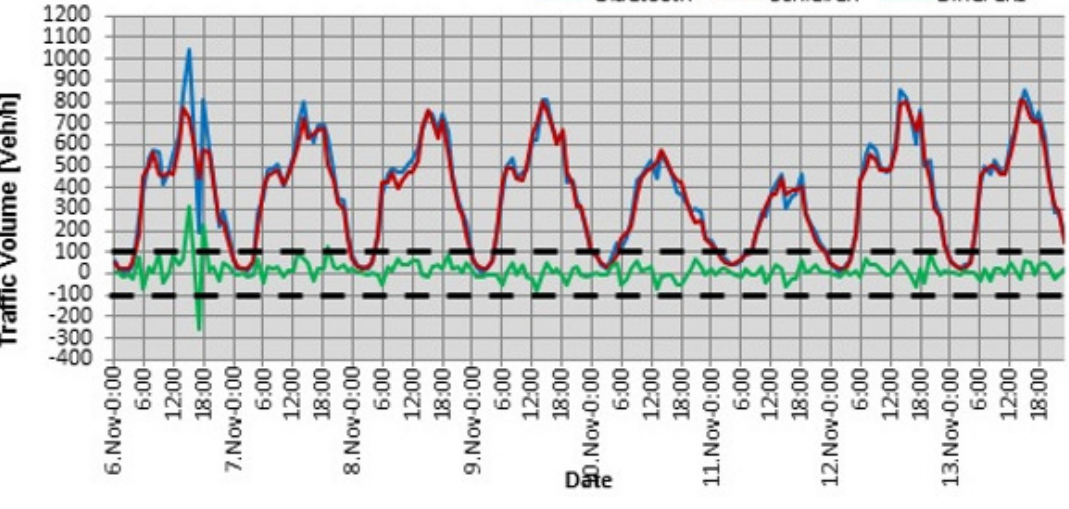
Figure 6: Bluetooth detections compared to loop